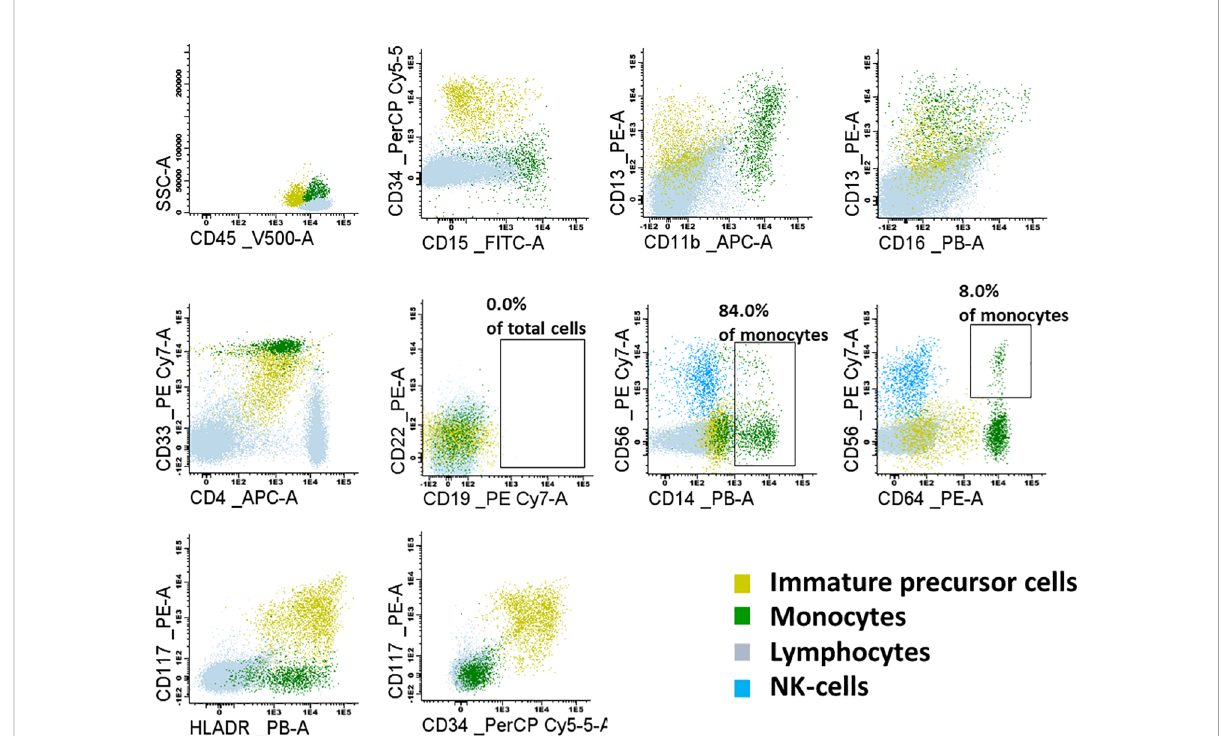
FIGURE 4 Flow cytometry dot-plots representing the lymphoid, monoid and immature precursor cell subsets in the examined bone marrow sample. Lymphoid subset was represented mostly by T-cells and NK-cells. No mature B-cells nor precursor B-cells were present. Monoid lineage was represented mainly by mature monocytes (84.0% of CD14+); 8% of monocytes were